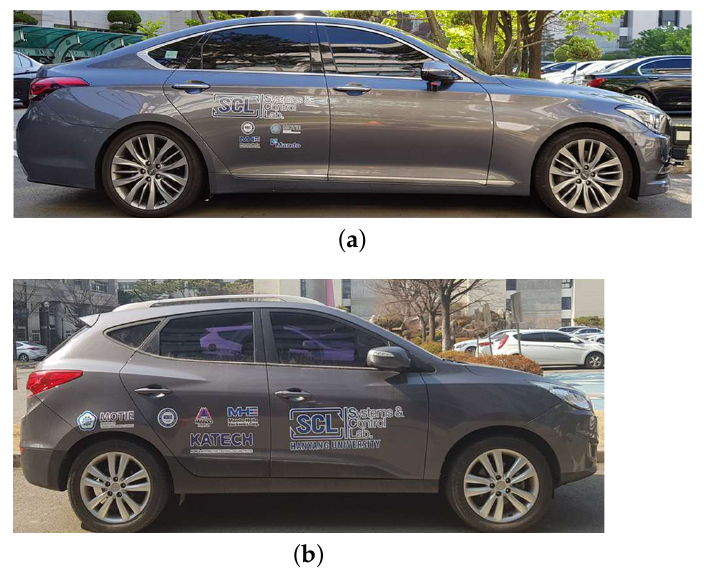
Figure 4. Vehicles used for experiment: ( a ) ego vehicle: Genesis DH from Hyundai and ( b ) object vehicle: Tucson IX from